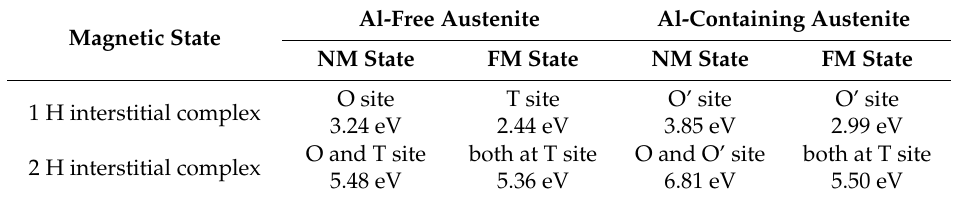
Table 1. The preferential occupying site of interstitial hydrogen atoms in Al-free and Al-containing austenites and the binding energies (eV) between austenites and interstitial hydrogen